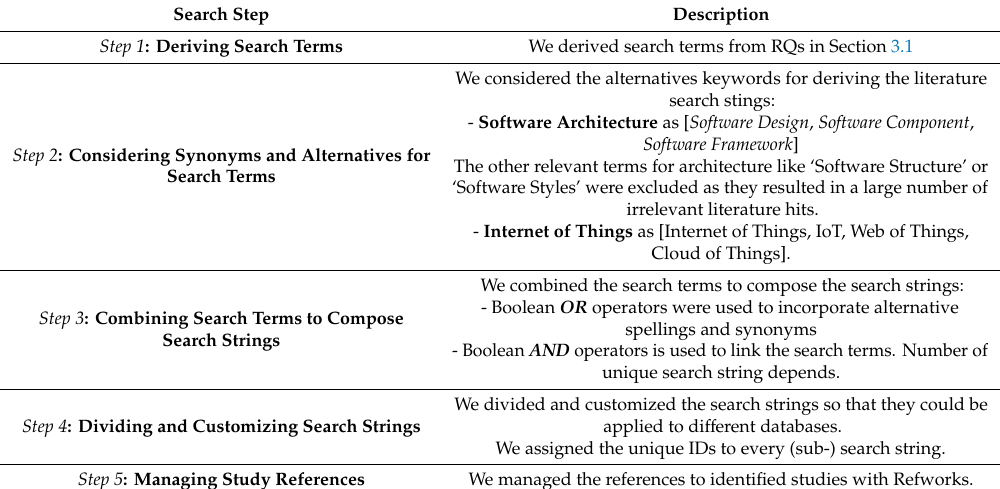
Figure 5. Identification and Selection of Primary Studies—Overview of Literature Search Process. Table 2. A summary of the strategic steps in the literature search